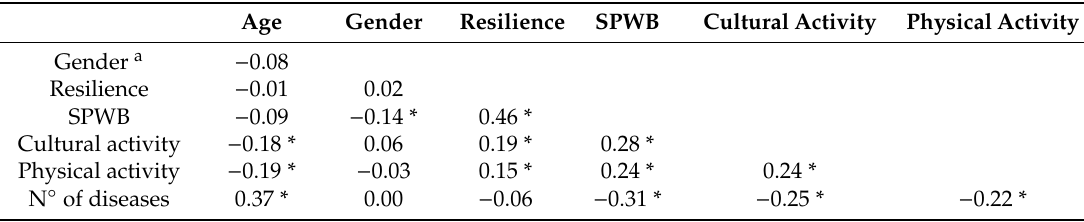
Table 2. Correlations of demographic, health, leisure activities, and well-being variables. Age Gender Resilience SPWB Cultural Activity Physical Activity Gender a − 0.08